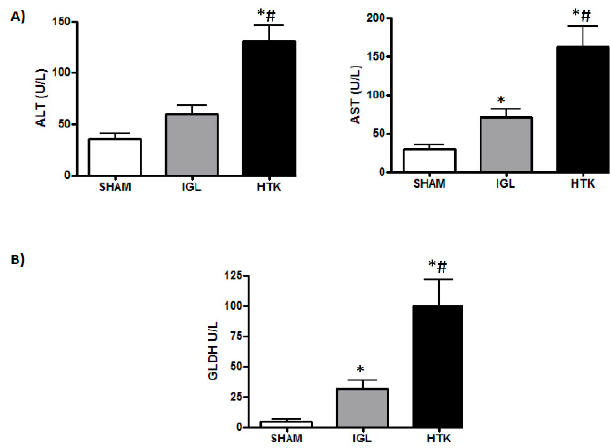
Figure 1. Liver injury ( A ) and mitochondrial damage ( B ) in fatty liver grafts preserved in Institute Georges Lopez (IGL-1) and histidine-tryptophan-ketoglutarate (HTK) vs. SHAM. Results are expressed as mean ± SEM ( n = 6). * p < 0.05 represent significant differences vs. SHAM and # p < 0.05 vs. IGL-1.